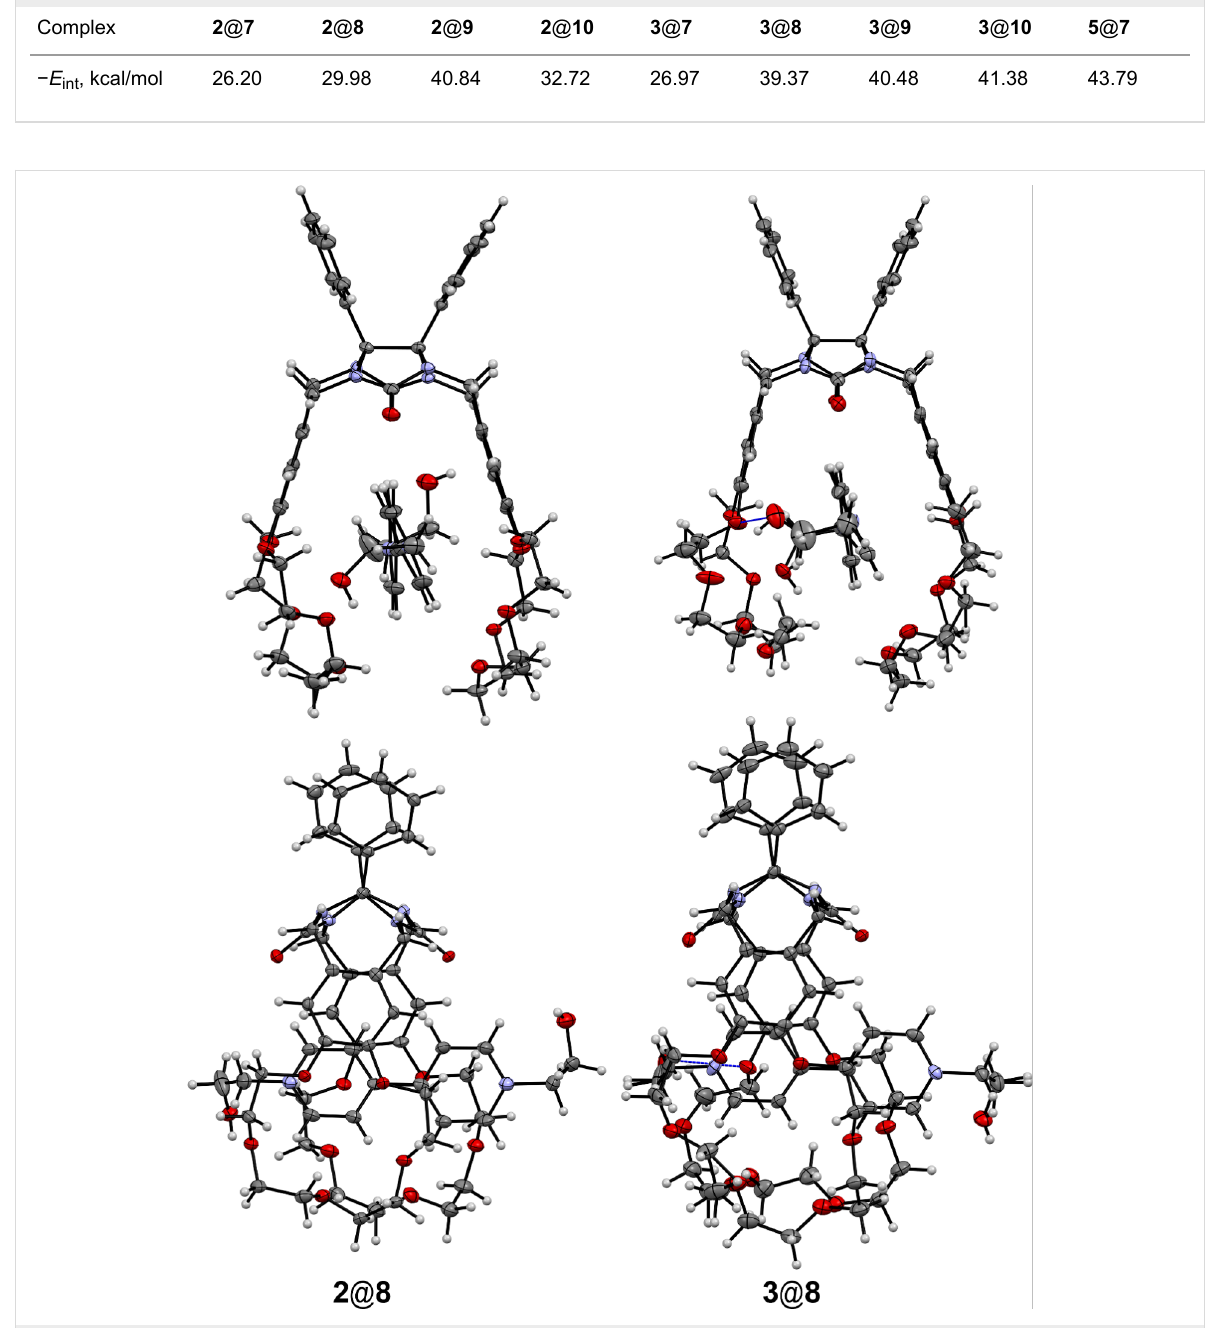
Figure 8: Molecular structures of complexes 2 @ 8 and 3 @ 8 . The hydrogen bonds are shown by blue lines. Anions and solvate molecules are omitted for clarity.